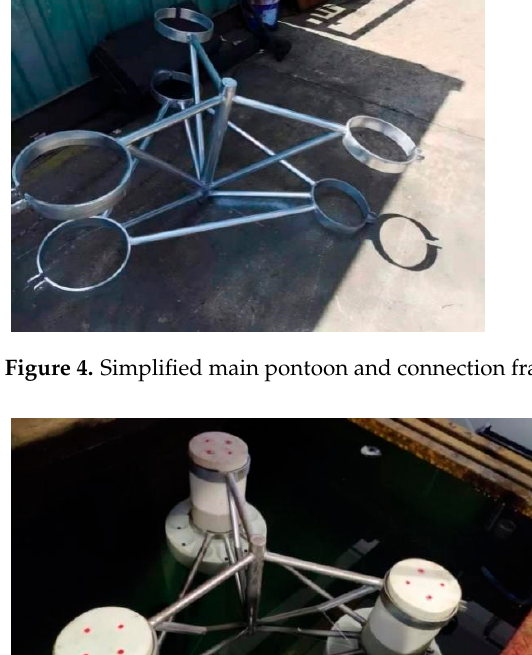
Figure 3. Simplified model.